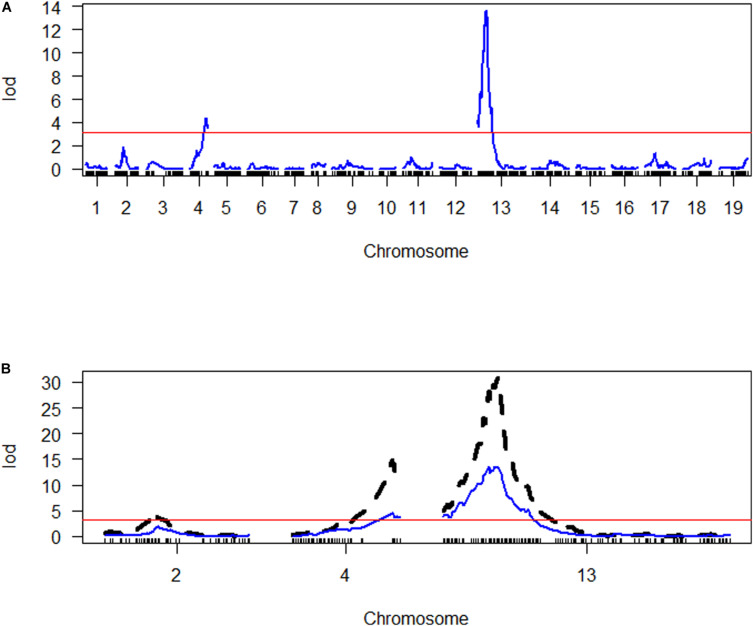
Genome scan of LOD scores for disease index (DI). (A) The LOD scores estimated by simple interval mapping (SIM). (B) The LOD scores for the chromosomes where QTLs were identified (A02 = chromosome 2, A04 = chromosome 4, C03 = chromosome 13); the LOD scores estimated by multiple QTL mapping are indicated in black, while the LOD scores estimated by SIM are indicated in blue. The red line in both graphs represents the LOD threshold determined by 1000 permutations.